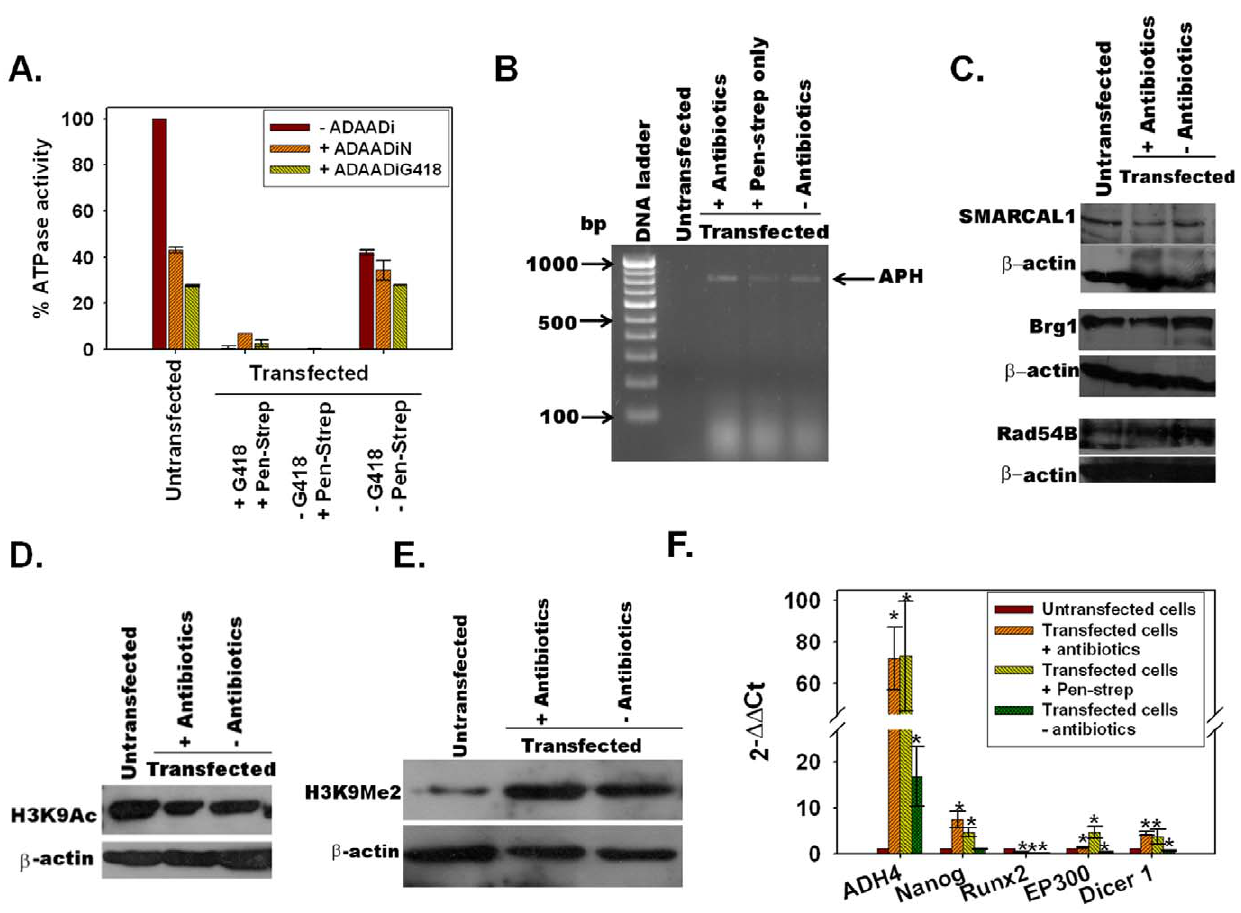
Figure 5. Production of ADAADi in Neuro2A cells leads to alterations in the epigenome. (A). Comparing the in vivo ATPase activity of SMARCAL1 present in untransfected Neuro2A cells and stably transfected Neuro2A cells grown as indicated post-selection. (B). APH transcript expression in untransfected and transfected Neuro2A cells. (C). SWI2/SNF2 expression in untransfected and stably transfected Neuro2A cells grown as indicated was analysed using polyclonal anti-SMARCAL1 antibody, anti-Brg1 antibody, and anti- Rad54B antibody. (D). Western blot analysis of H3K9Ac levels in untransfected and stably transfected Neuro2A cells. (E). Western blot analysis of H3K9Me2 levels in untransfected and stably transfected Neuro2A cells grown as indicated by western blot. b -actin was used as loading control in these experiments. (F). The levels of ADH4, Nanog, Runx2, EP300, and Dicer1 was estimated by quantitative RT-PCR. The transcript levels in stably transfected cells were calculated with respect to the levels present in untransfected cells. The data are an average of two independent experiments, each experiment done in duplicate. Error bars indicate standard deviation and stars indicate statistical significance at P , 0.05. The P-values are given in Table S3.